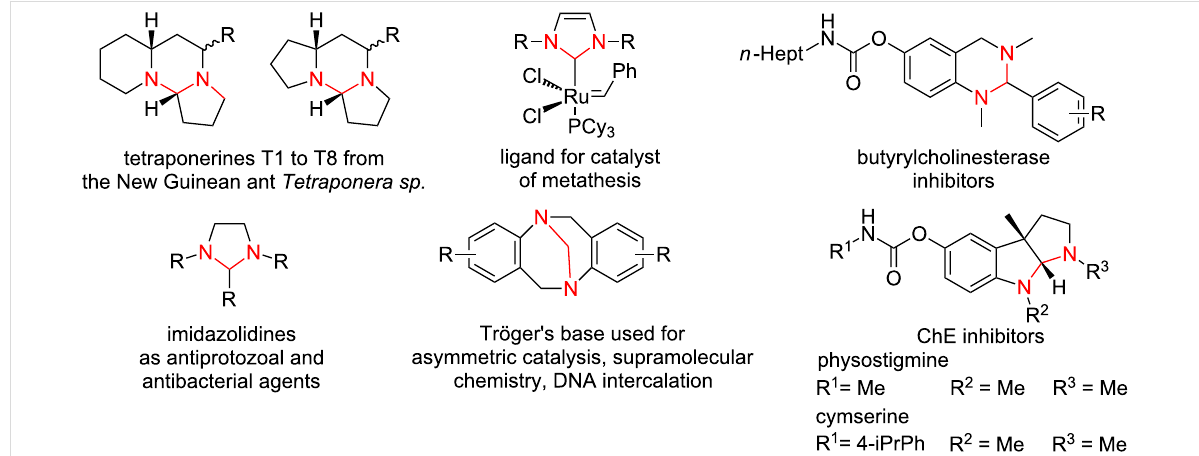
Figure 1: Compounds described in the literature containing an aminal core for various applications. The aminal structure is highlighted in red.